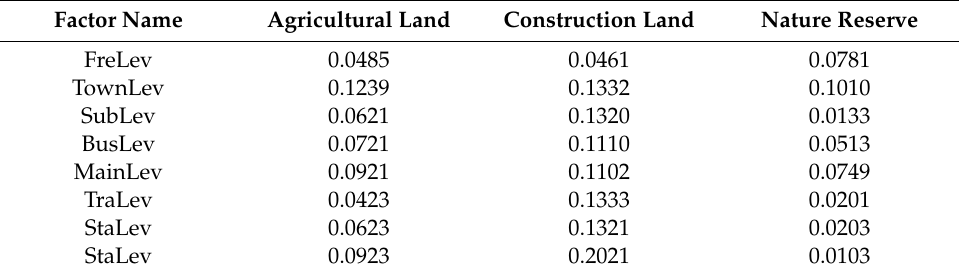
Table 3. Weight parameters of suitability